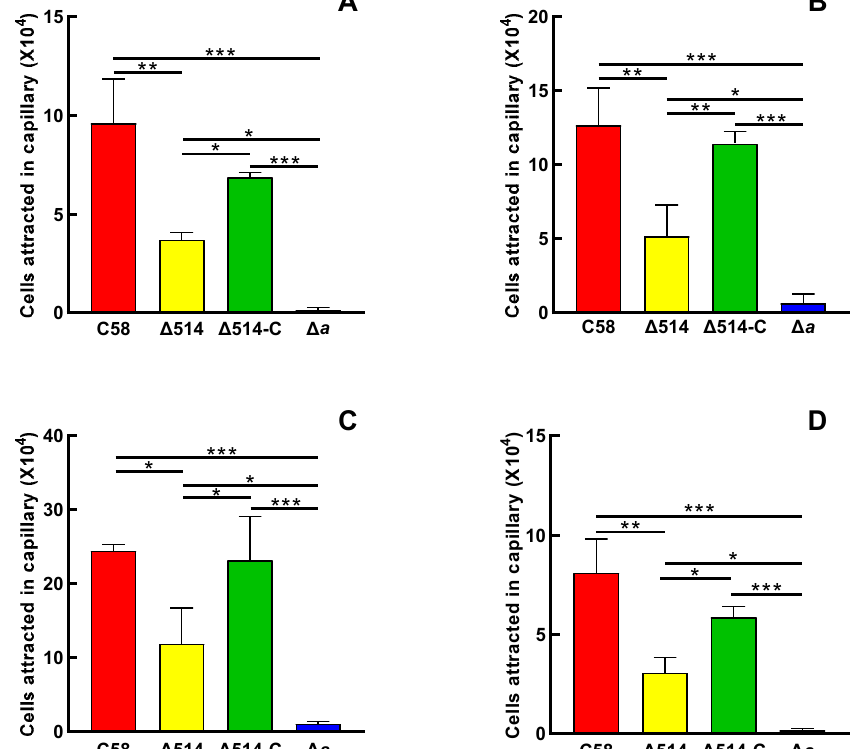
Figure 4. Effect of MCP 514 deficiency on the chemotactic responses of A. fabrum to sucrose ( A ), valine ( B ), citric acid ( C ) and acetosyringone ( D ). A. fabrum cells in the middle-log phase were collected, washed and then adjusted to an OD 600nm of 0.1 with chemotaxis buffer. Capillary tubes containing chemotaxis buffer with 10 − 6 mol/L sucrose, 10 − 3 mol/L valine, 10 − 3 mol/L citric acid, or 10 − 7 mol/L acetosyringone were inserted into the cell suspensions for 1 h at room temperature (25 °C). Cells